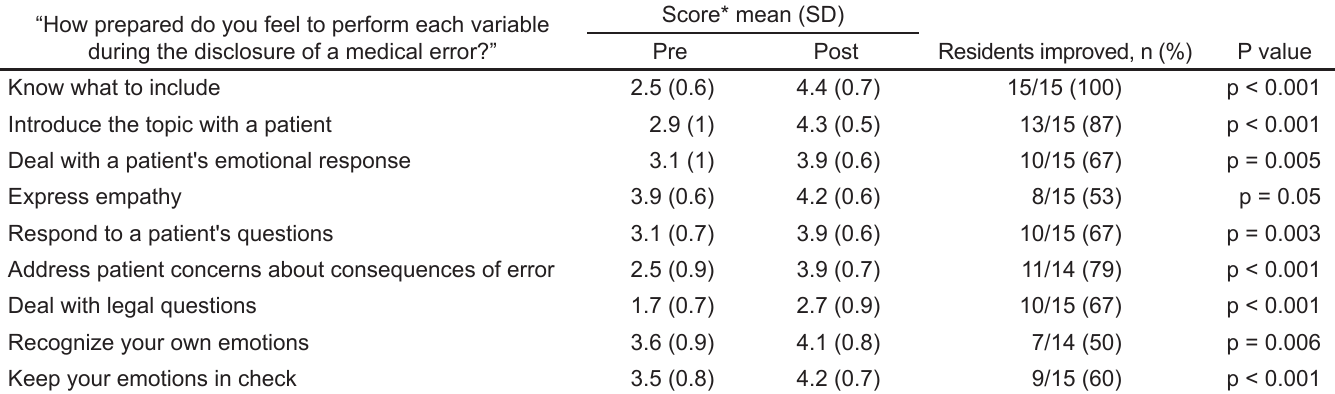
Table 1. Self-efficacy in error disclosure among 15 emergency medicine residents.